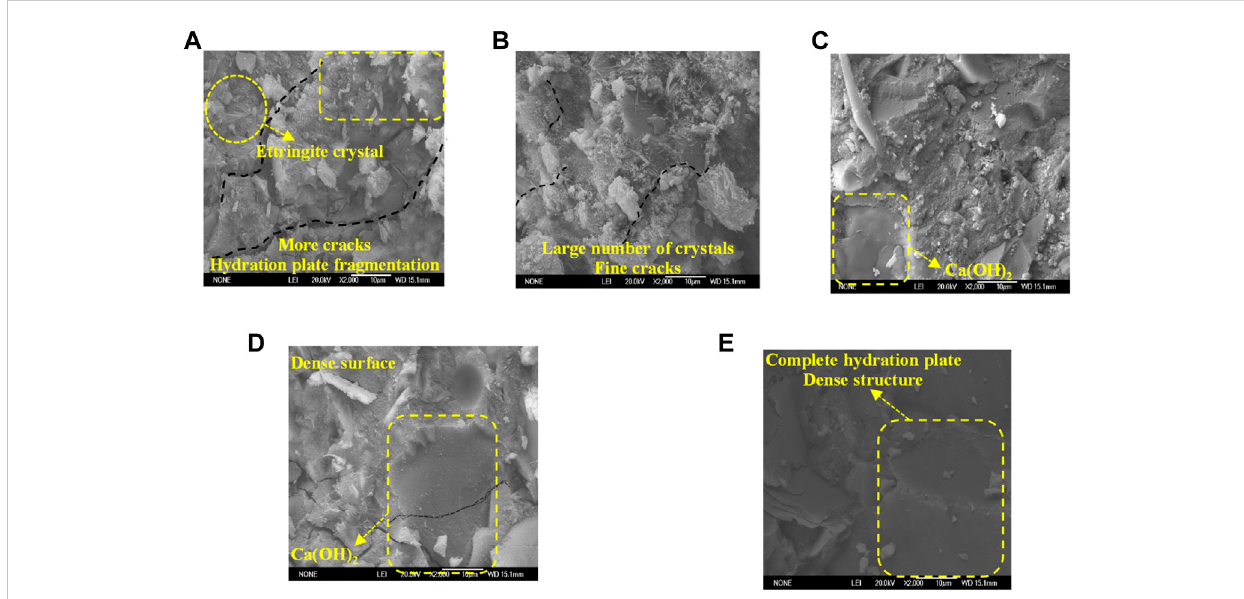
FIGURE 4 Microscopic scanning photos after 240 d of erosion (2000×). (A) Microscopic scanning image of S1 specimens. (B) Microscopic scanning image of S2specimens. (C) Microscopic scanningimageofS3 specimens. (D) MicroscopicscanningimageofS4specimens. (E) Microscopic scanning imageofS5 specimens.